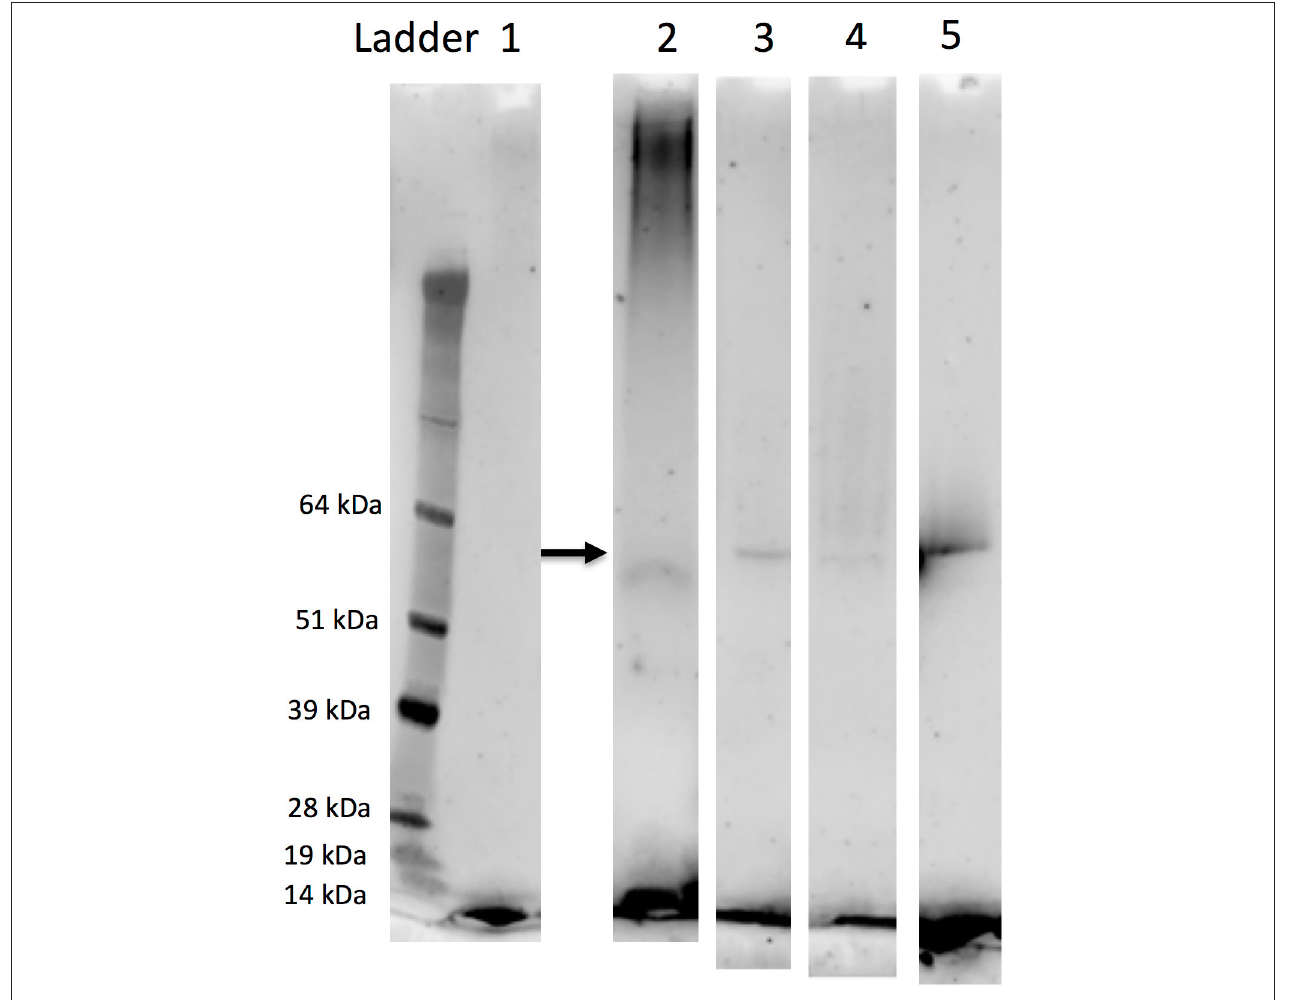
FIGURE 2 | Western blot performed using a Drosophila melanogaster α -amylase-specific antibody toward the purified α -amylases from the oral secretions of larvae of Chilo partellus (1), Busseola fusca (2), Sesamia calamistis (3), and Sesamia nonagrioides (4). Ladder: molecular weight markers (pre-stained SeeBlue Plus2, Thermo Fischer). 5: α -amylase from Drosophila melanogaster